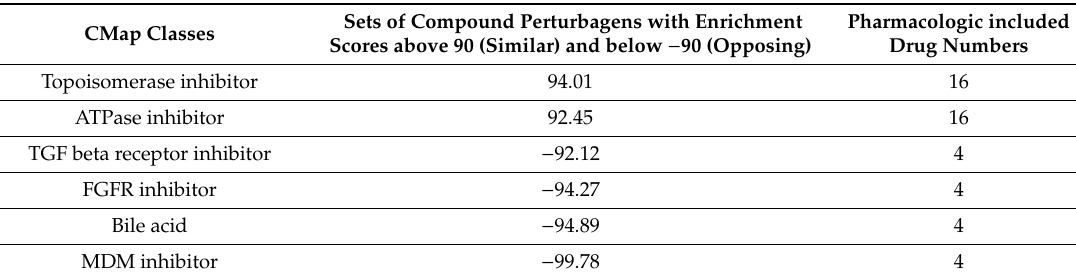
Table 1. Significant perturbagens class obtained from Connectivity Map. Pharmacologic class of perturbagens reflected with enrichment scores above 90 (similar) and below − 90 (opposing) deciphered via Connectivity Map from the hairpin screening for the drug doxorubicin.